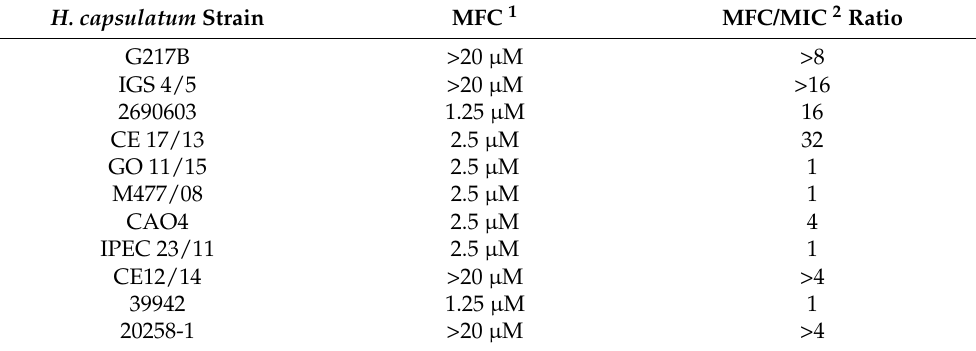
Table 2. Fungicidal activity, determined in three independent experiments, of mebendazole against 11 H. capsulatum